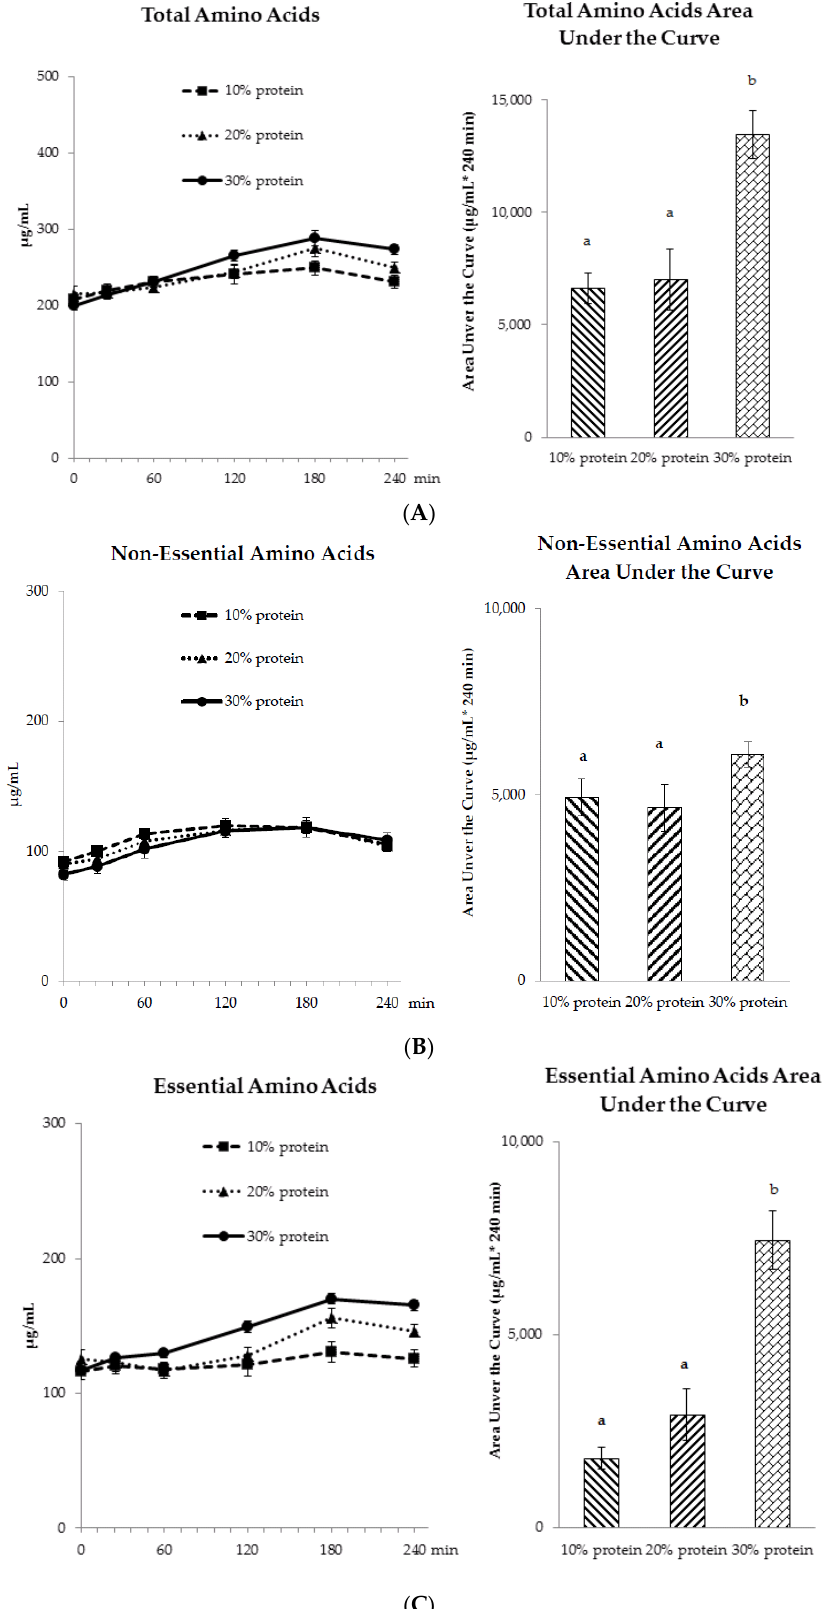
Figure 5. Postprandial plasma free ( A ) total amino acids; ( B ) non-essential amino acids; and ( C ) essential amino acids profiles at the end of each 4-week period (day 28). a,b : No effect of protein source was observed; values with different letters differ significantly, p <